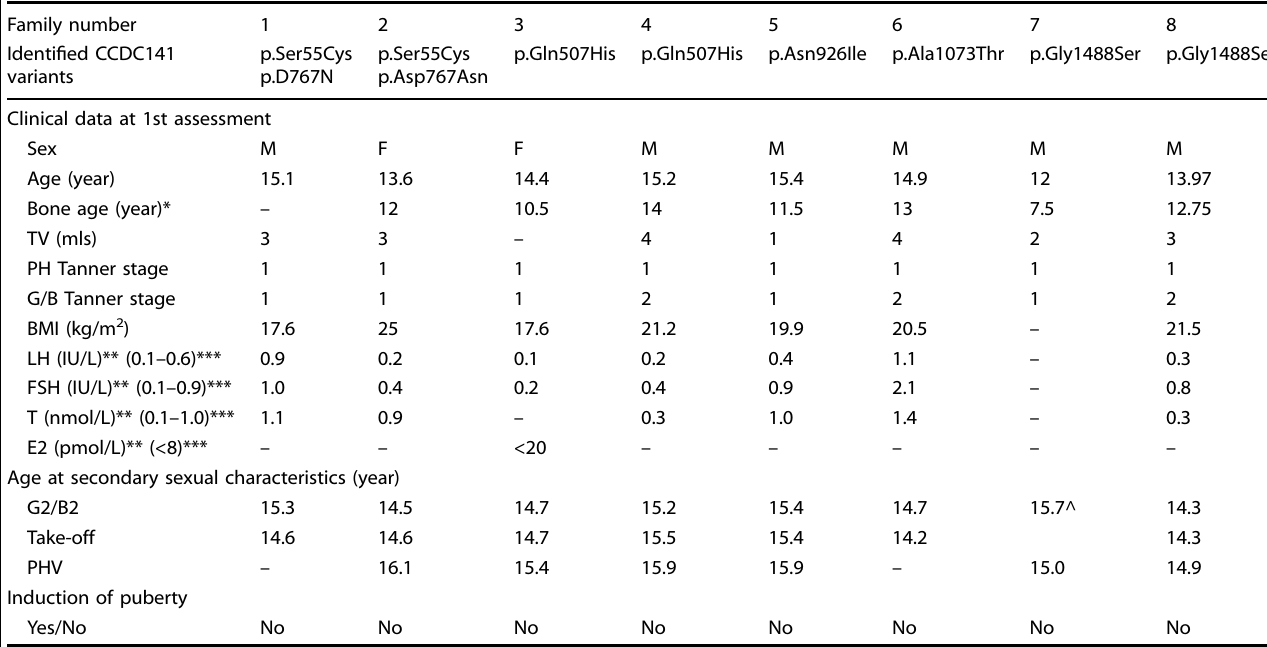
Table 1. Clinical data of probands carrying CCDC141